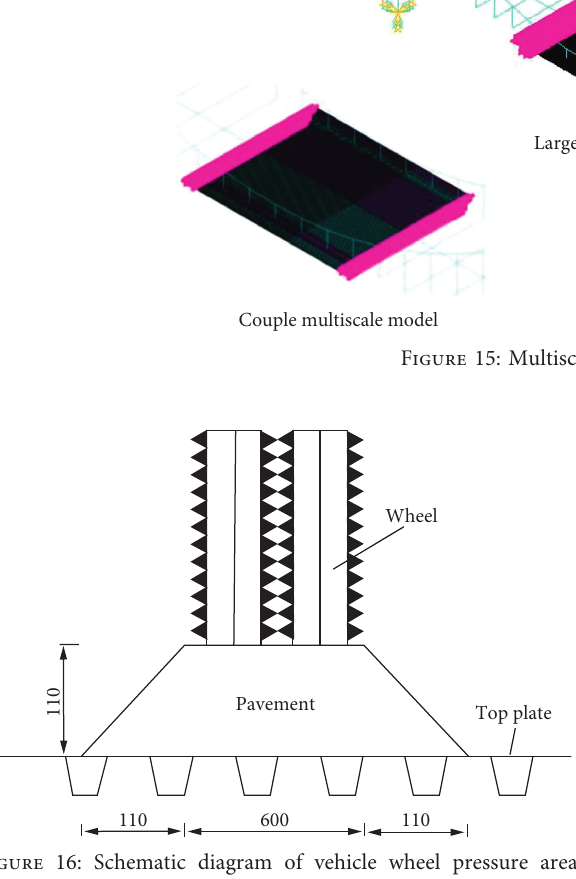
Figure 16: Schematic diagram of vehicle wheel pressure area diffusion (unit: